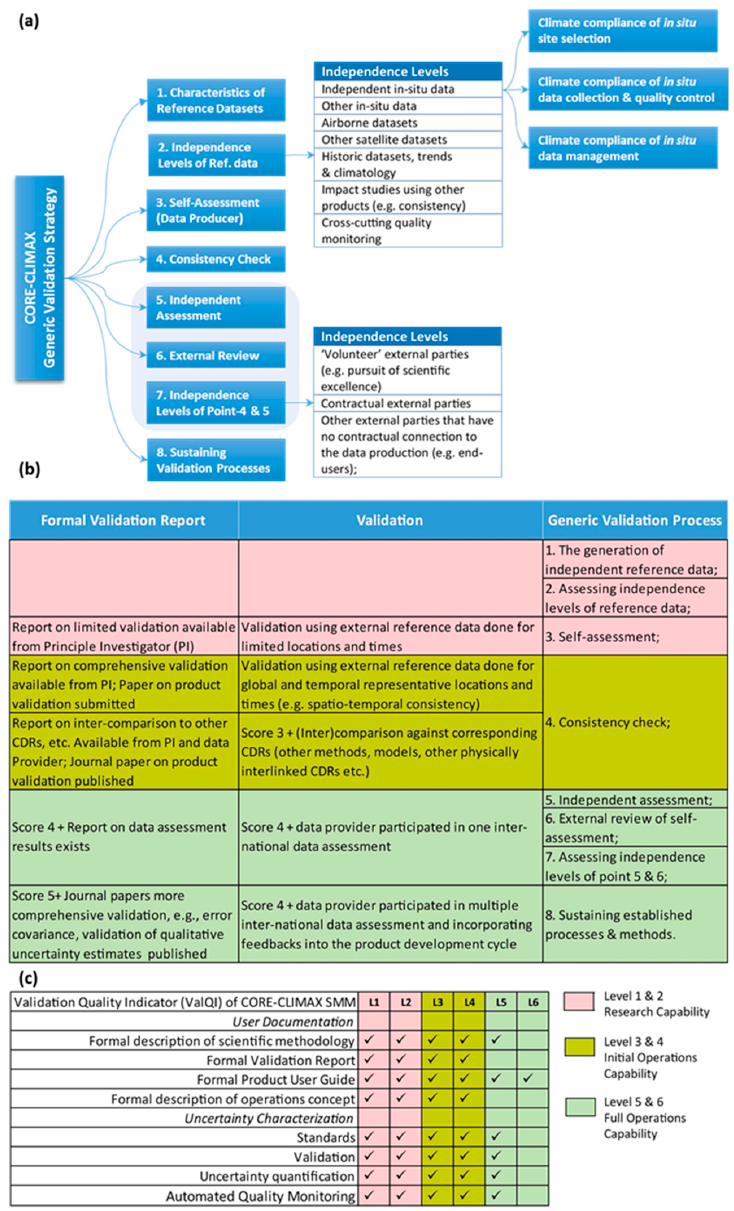
Figure 3. ( a ) CORE-CLIMAX generic validation strategy for space-based ECV CDRs; ( b ) Validation Traceability Quality Indicator (ValQI): mapping the CORE-CLIMAX generic validation process to the sub-thematic areas of CORE-CLIMAX system maturity matrix: “Validation” and “Formal Validation Report”; ( c ) example of applying ValQI for evaluating the validation maturity of ESA-CCI Soil Moisture CDR (Phase I). The above evaluation indicates that the automated quality monitoring of ESA-CCI Soil Moisture has been partially implemented but the resulting quality feedback has not yet been incorporated into metadata or documentation. The assessment helps the ESA-CCI Soil Moisture Project team to identify the potentially needed and targeted studies to improve the climate quality of their soil moisture products. The generic validation strategy presented above can be mapped to the CORE-CLIMAX system maturity matrix (SMM) [11,57], under the “Formal Validation Report” and “Validation” in the subthemes of “User documentation” and “Uncertainty characterization,” respectively. This mapping indicates the applicability of using the corresponding validation-relevant subthemes of SMM as the